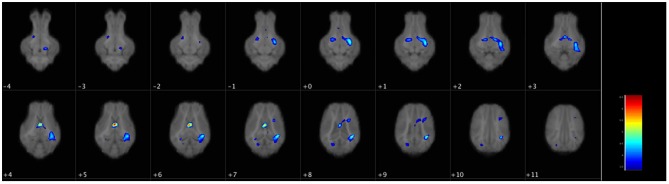
Voxel-based morphometry map of increased white matter clusters in HF piglets compared to CON. Voxel-based morphometry revealed HF fed piglets have more white matter in several key regions compared to CON fed piglets regardless of birth weight. These areas were the next to the lateral ventricle (periventricular white matter), the internal capsule, the left and right cortices, the midbrain, and the hypothalamus. Each image is a 1 mm axial slice composite of all piglet brains. The color bar represents the pseudo-T statistic indicating level of significance, with red indicating highest statistical difference between voxels. Values are 6–8 replicate pigs with MRI data collected at 26–29 days of age as described in Table 3. AGA, appropriate for gestational age; SGA, small for gestational age; CON, control; HF, hydrolyzed fat.